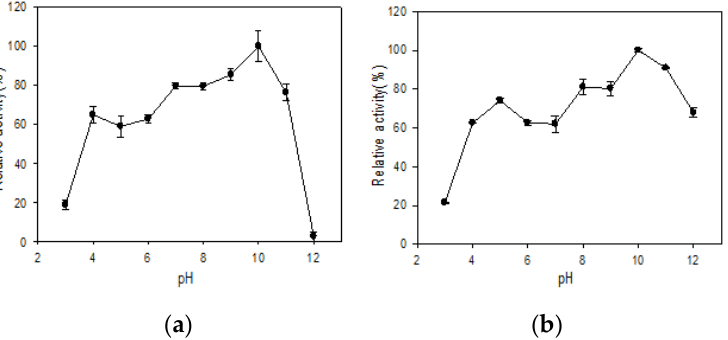
Figure 4. Effect of pH on stability. ( a ) R5-SazCA; ( b ) R5-SazCA-SP. The highest activity was set as 100%. The pH stability was determined by pre-incubating the enzyme solution with a buffer system at a volumetric ratio of 1:9 (enzyme: buffer system) for 30 min; the buffer system contained 150 mM glycine, 150 mM H 3 PO 4 , and 150 mM Tris-base with pH adjusted to 3–12. After incubation, the enzyme solution was assayed for its residual CO 2 hydratase activity.